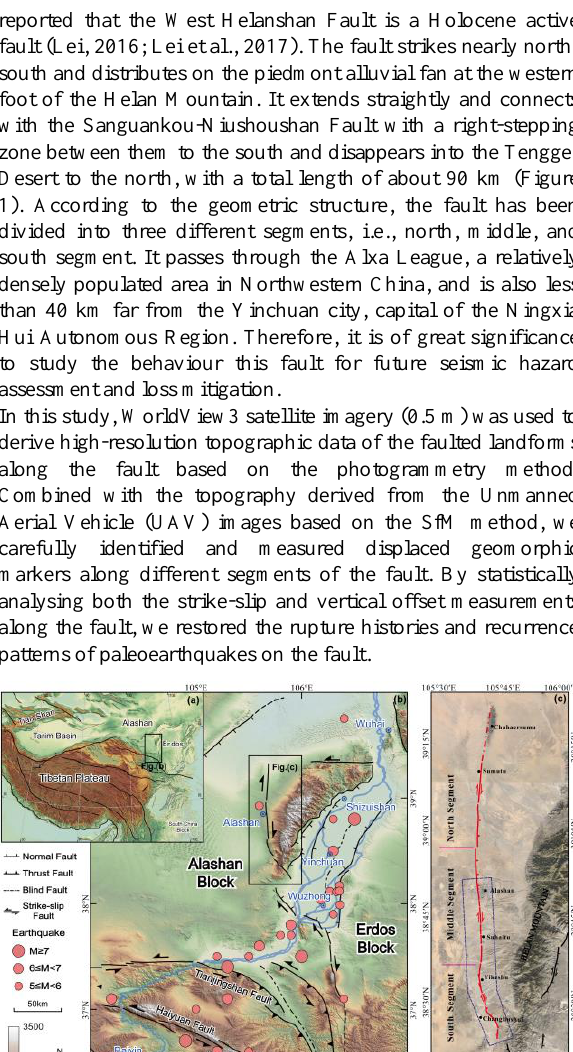
is the Google Earth image. The blue polygon indicates the coverage area of the WordView-3 satellite